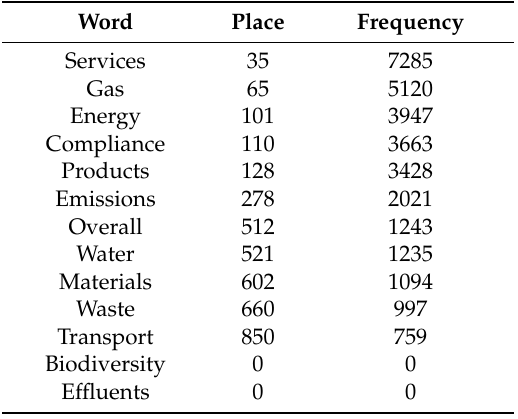
Table 5. Frequency of use of the words related with EPIs.